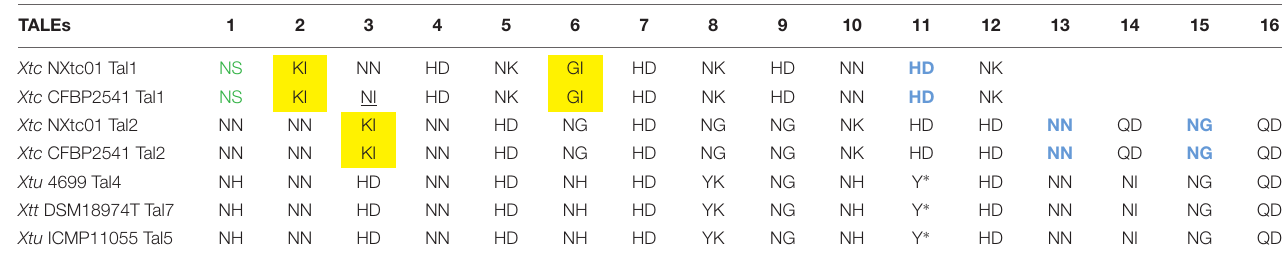
TABLE 2 | Comparison of RVDs in Tal1 and Tal2 with RVDs in other X. translucens strains and